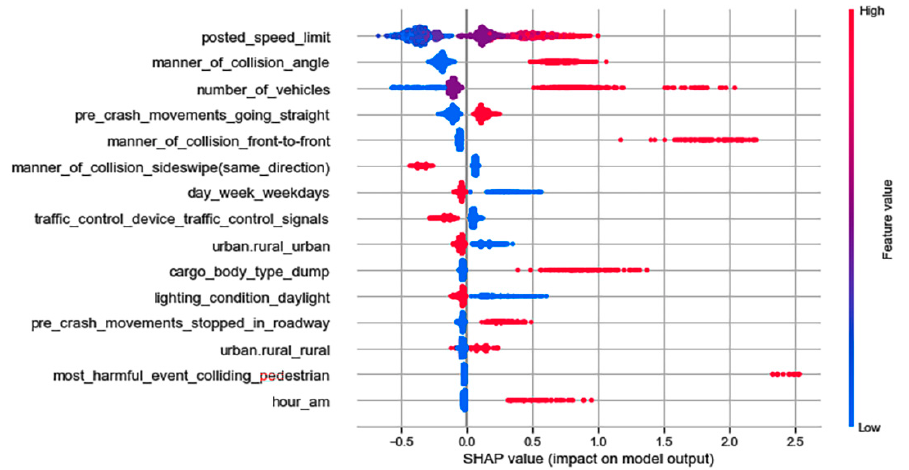
Figure 4. Summary plot for top 15 important features in CL2-based model.